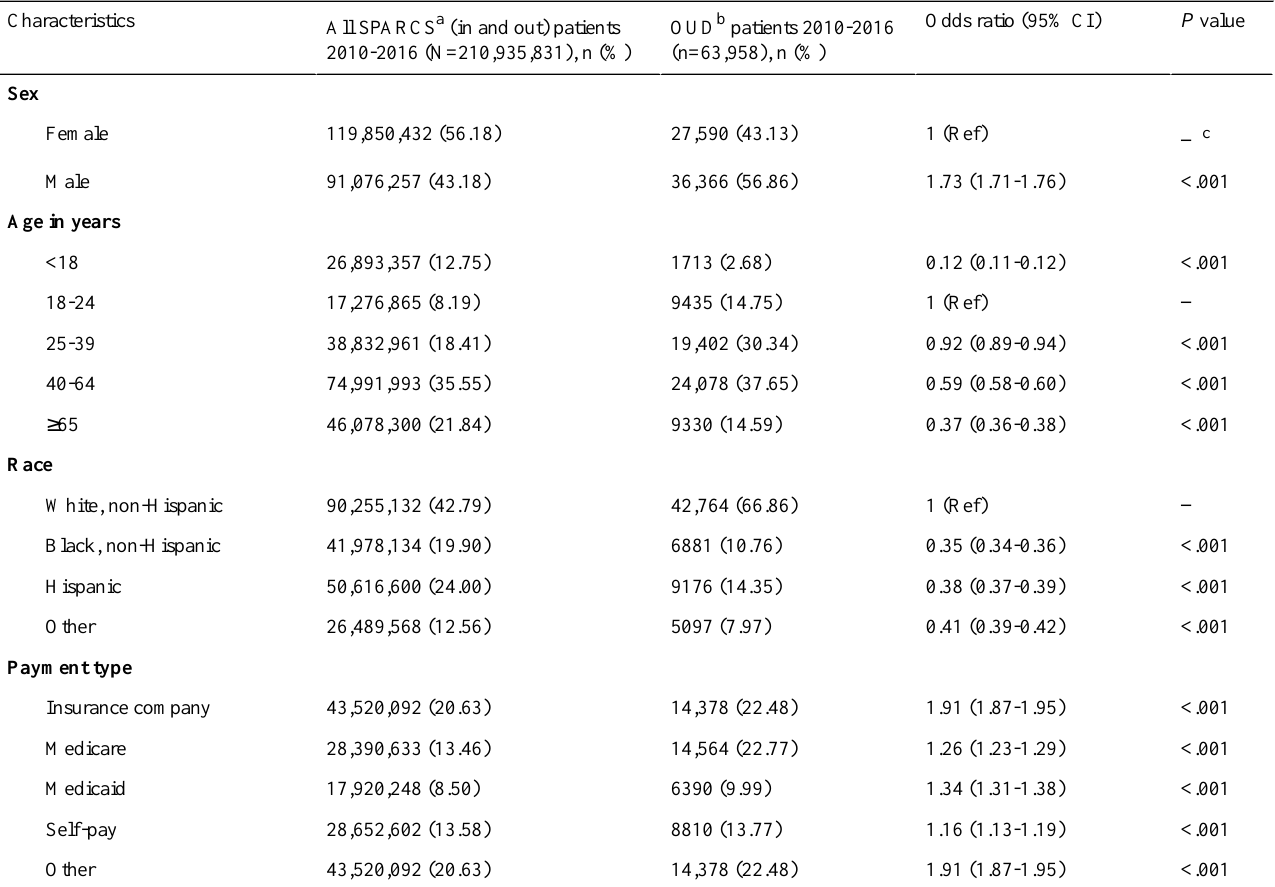
Table 1. Characteristics of Statewide Planning and Research Cooperative System database patients associated with opioid use disorders in New York State,